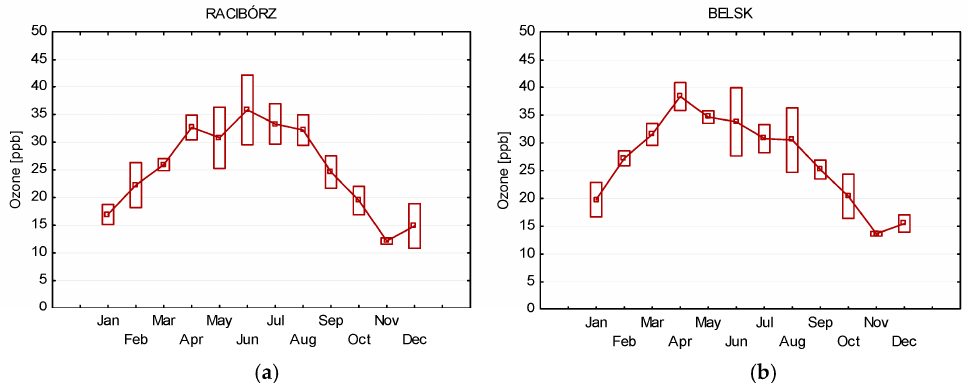
Figure 4. Monthly average surface O3 concentrations in Racibórz ( a ) and at Belsk ( b ) for the period September 2018-September 2021. The point displays the mean value; the box shows the range: mean ± 1 standard deviation.